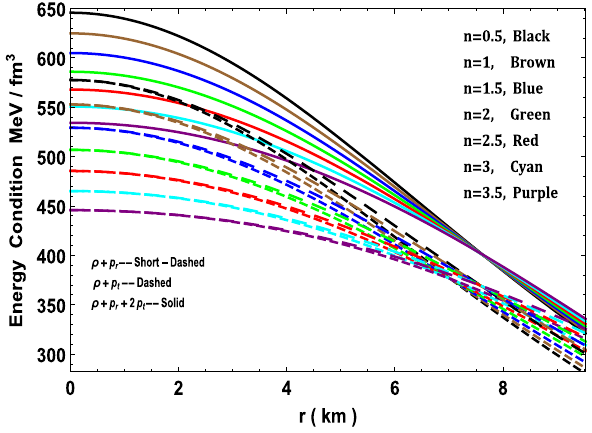
Fig. 11 Variation of energy conditions (EC) with radial coordinate r for 4U 1608-52 ( M = 1 . 74 M (cid:9) , R = 9 . 528 km) by taking a = 0 . 001 km − 2 and β = 0 .